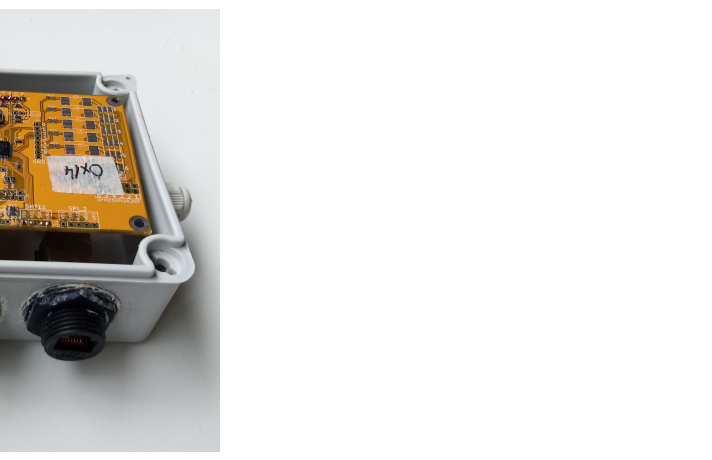
Figure 7. The ARM-Node inside IP67 enclosure. The rugged RJ45 connectors and cable glands are show.